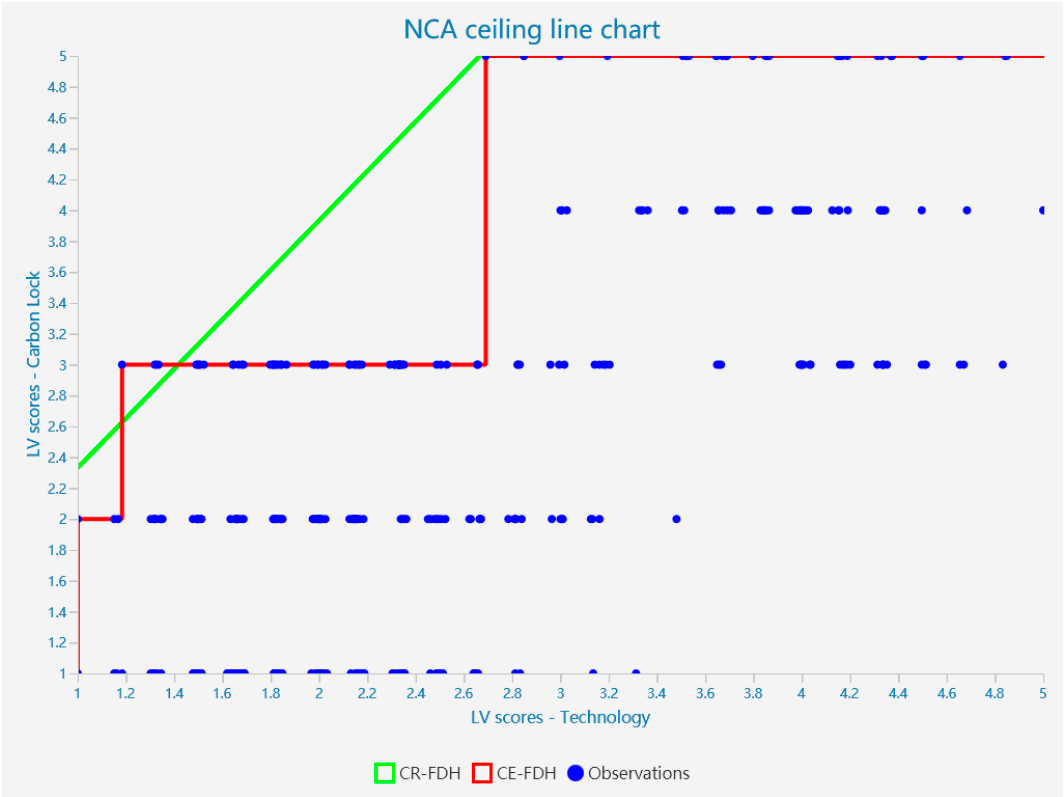
Figure 4. Scatterplot of the analysis of the necessity of technical factors for carbon unlocking.